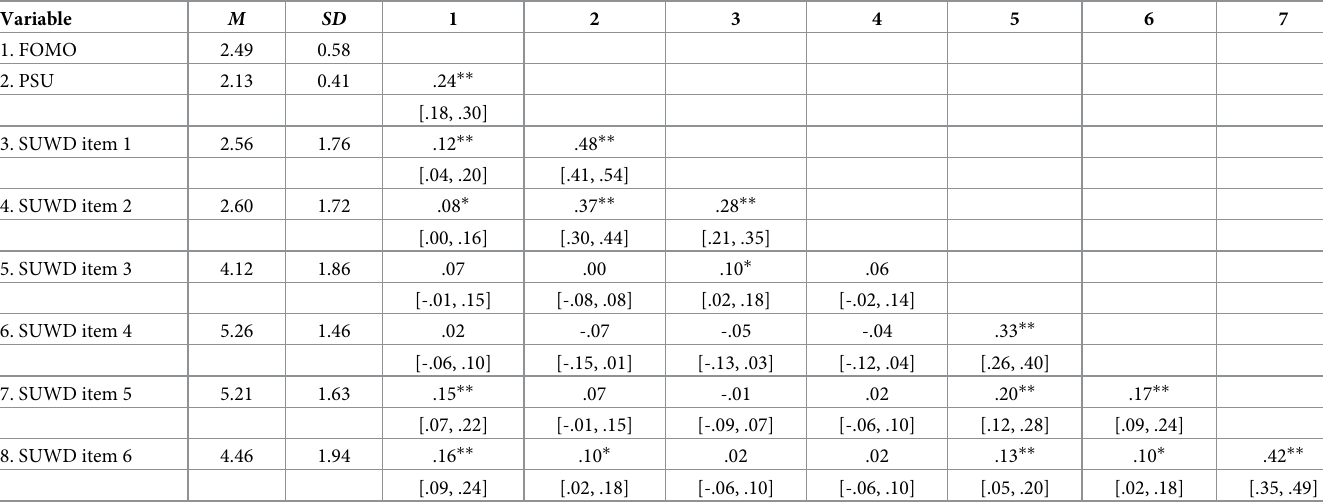
Table 4. Pearson correlations between fear of missing out (FOMO), problematic smartphone use (PSU), and smartphone use while driving (SUWD). Variable M SD